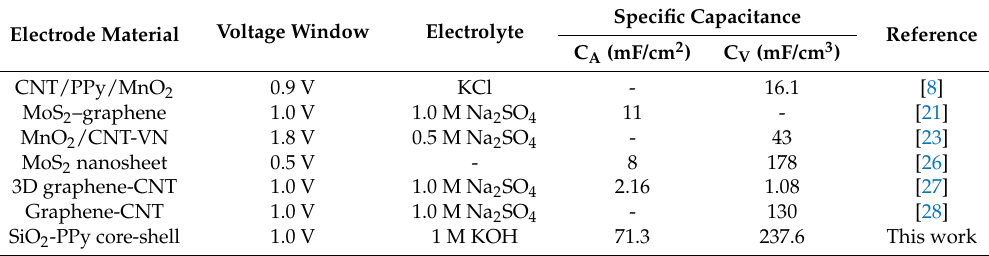
Table 1. Electrochemical performance of supercapacitors based on the two electrode cell. Electrode